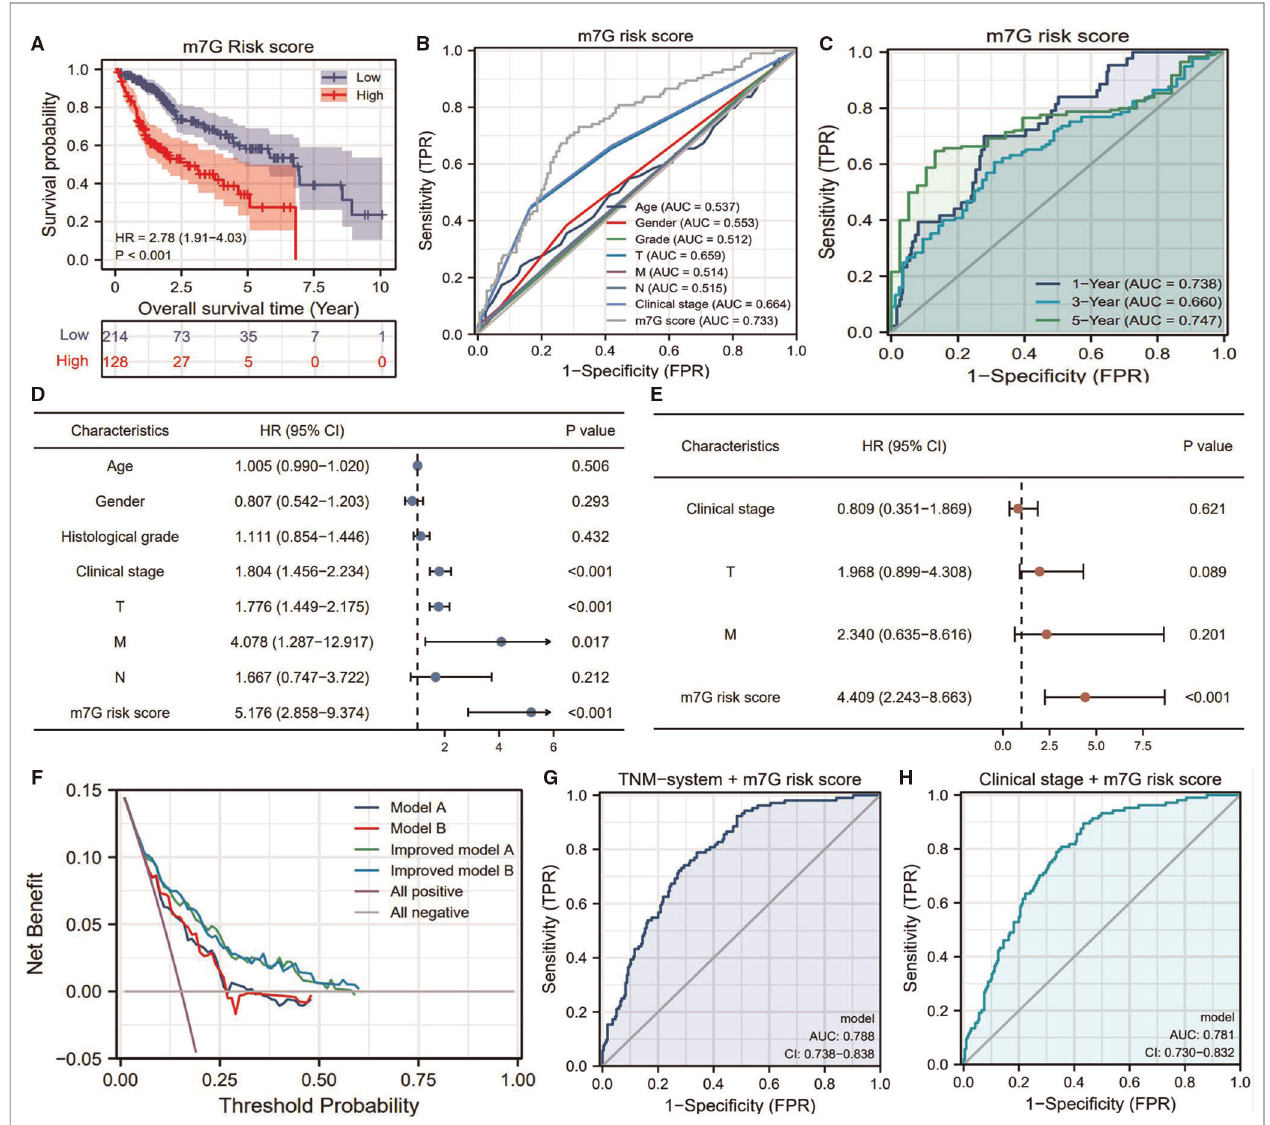
FIGURE 3 | Prognostic value of m7G risk signature in HCC. ( A ) Overall survival difference between the high- and low-m7G-risk groups based on the Kaplan – Meier method. ( B ) ROC curves of clinicopathological features and m7G risk scores for predicting OSR. ( C ) Time-dependent ROC curves of the m7G risk score for predicting OSR. ( D ) Univariate independent prognostic analysis. ( E ) Multivariate independent prognostic analysis. ( F ) DCA results. “ Model A ” is the traditional prognostic model composed of age, histological grade, and TNM staging (blue line). “ Model B ” is the traditional prognostic model composed of age, histological grade, and clinical stage (red line). “ Model C ” is the improved model A with the m7G risk score (green line). “ Model D ” is the improved model B with the m7G risk score (light blue line). ( G – H ) Improvements brought by the m7G risk score in the predictive accuracy of TNM staging and clinical stage. OSR, overall survival rate; HR, hazards ratio; AUC, area under curve; TPR, true-positive rate; FPR, false-positive